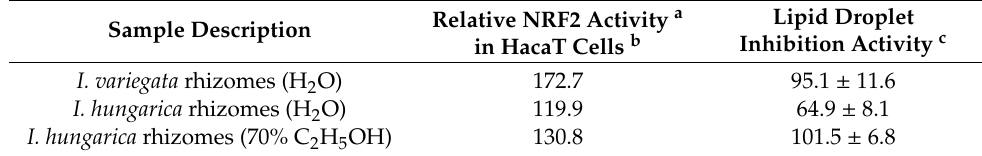
Table 7. Antioxidant capacity expressed as NRF2 activity and lipid droplets activity of Iris